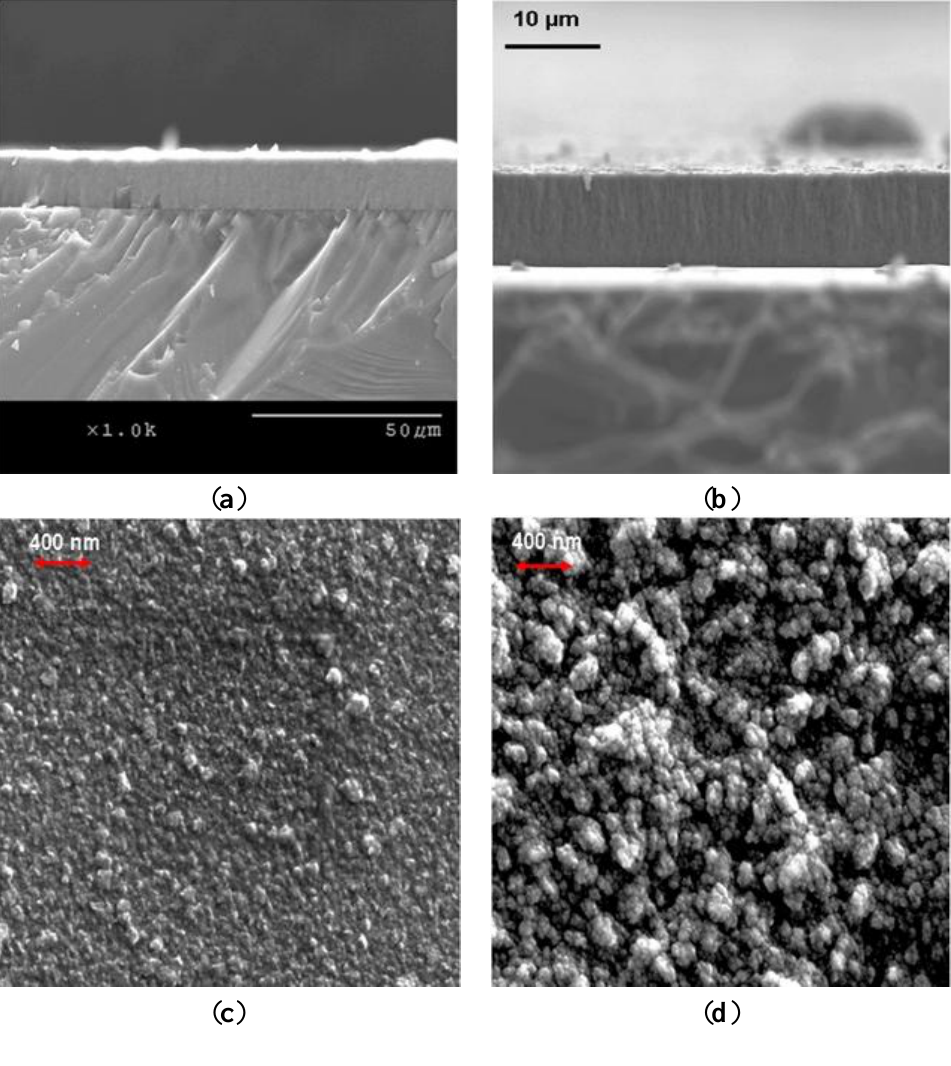
Figure 2. ( a ), ( b ): NSD films grown on silicon substrates using chemical vapor deposition (CVD) chamber pressures of 12 kPa and 9kPa, respectively; ( c ), ( d ): Surface morphologies of NSD films grown using GC1 and GC2 gaseous chemistries,